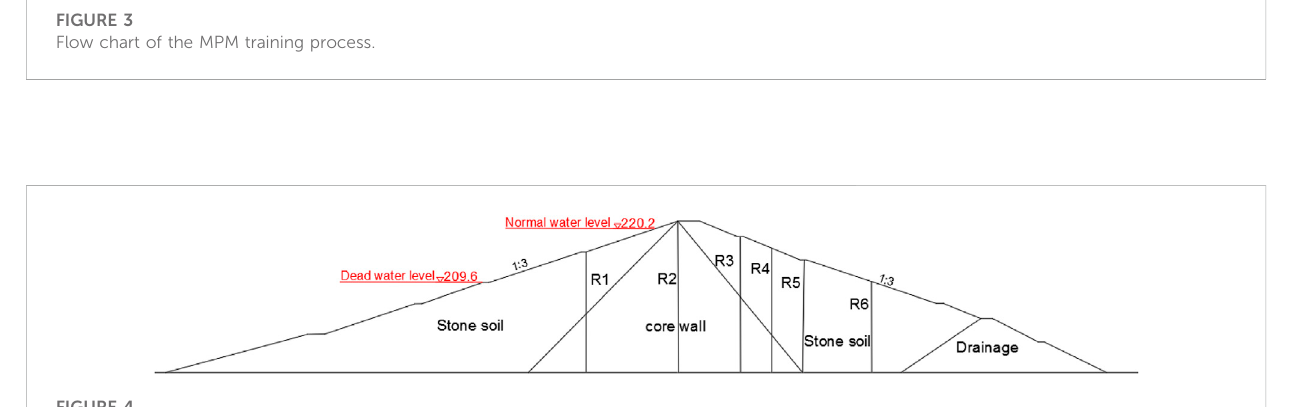
FIGURE 4 Piezometric tubes distribution of the Naban earth dam.